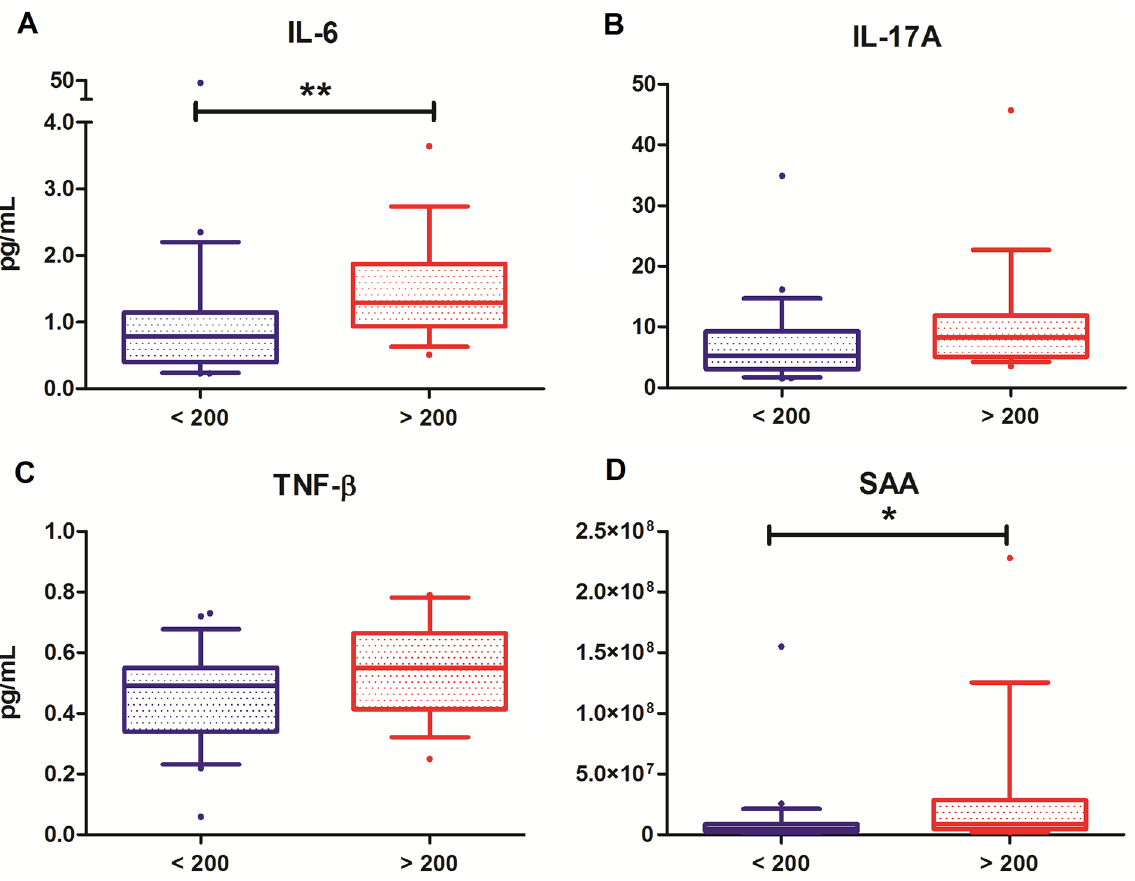
Fig 2. Distribution of serum biomarker levels in patients with normal (blue, < 200 mg/kg) and increased (red, > 200 mg/kg) fecal calprotectin levels, shown in boxplots. (A) Serum IL-6 levels (pg/mL). (B) Serum IL-17A levels (pg/mL). (C) Serum TNF- β levels (pg/mL). (D) Serum SAA levels (pg/mL). (cid:3) P < 0.05; (cid:3)(cid:3) P < 0.01.